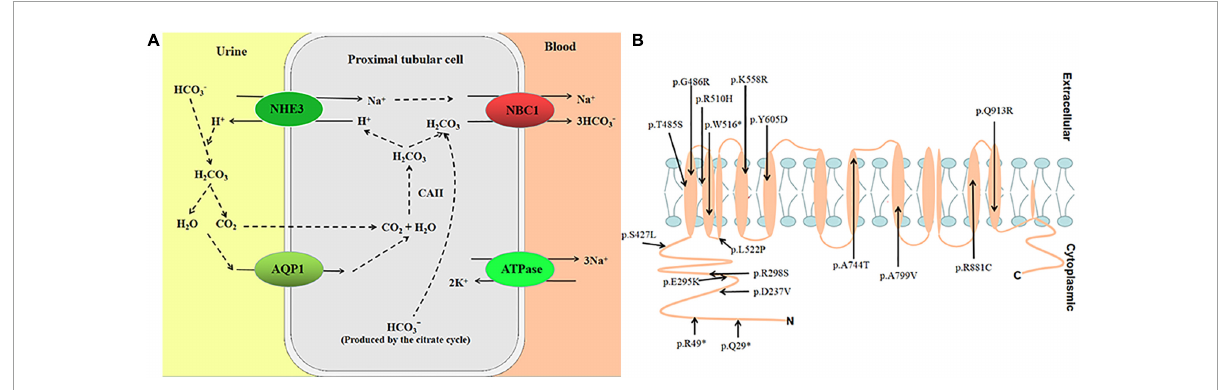
FIGURE1 (A) Transepithelial HCO 3 – transport is mediated by the coupling of apical Na + /H + exchange (NHE3) and basolateral NBC1 functioning as an electrogenic Na + -CO 32 – cotransporter with a 1:2 charge transport stoichiometry. (B) Putative location of variants in